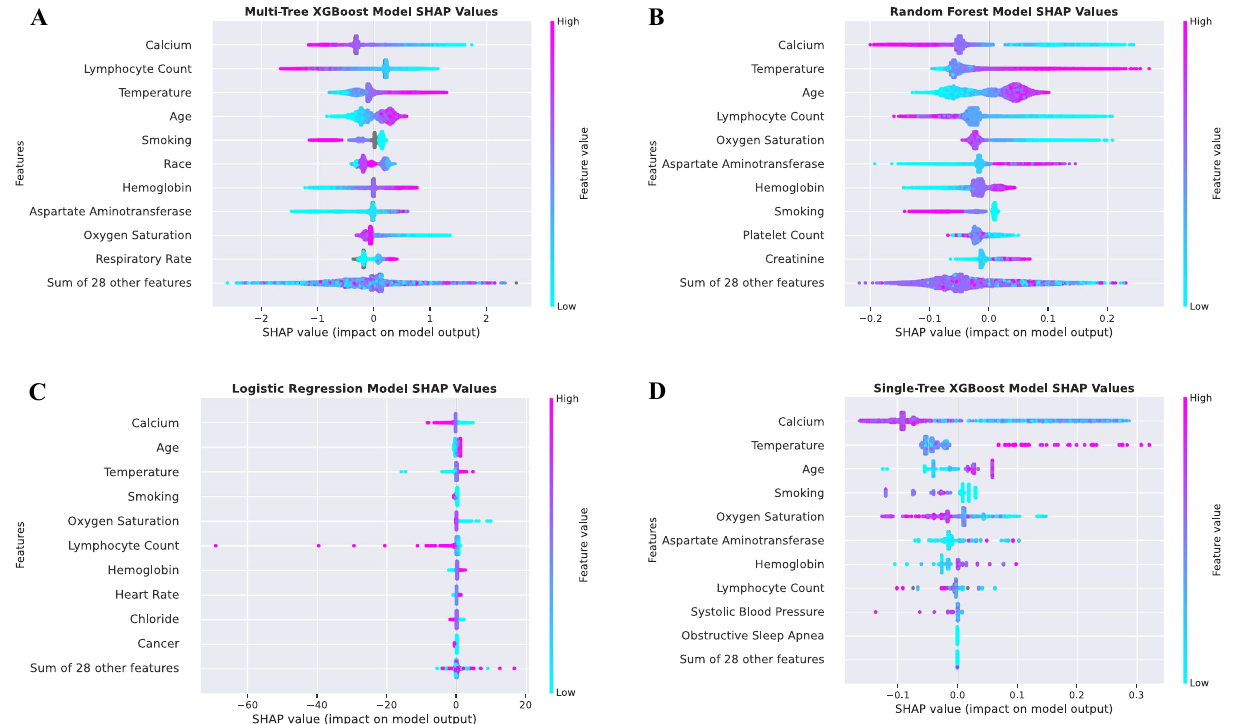
Figure 2. Feature importance across all four models. SHapley Additive exPlanations (SHAP) beeswarm plots of ( A ) the multi-tree XGBoost model, ( B ) the random forest model, ( C ) the logistic regression model, and ( D ) the single-tree XGBoost model. Features are ranked in order of decreasing mean absolute SHAP value. The SHAP value distribution of the top ten most predictive features in each model is displayed. The SHAP values on the x-axis of the tree-based models have log-odds units, while the SHAP values on the x-axis of the logistic regression model have probability units. For each feature, each patient is represented by a single point, and the x-position of each point represents the impact of that feature on a given patient. The color of each point corresponds to the patient’s value for that feature, ranging from low to